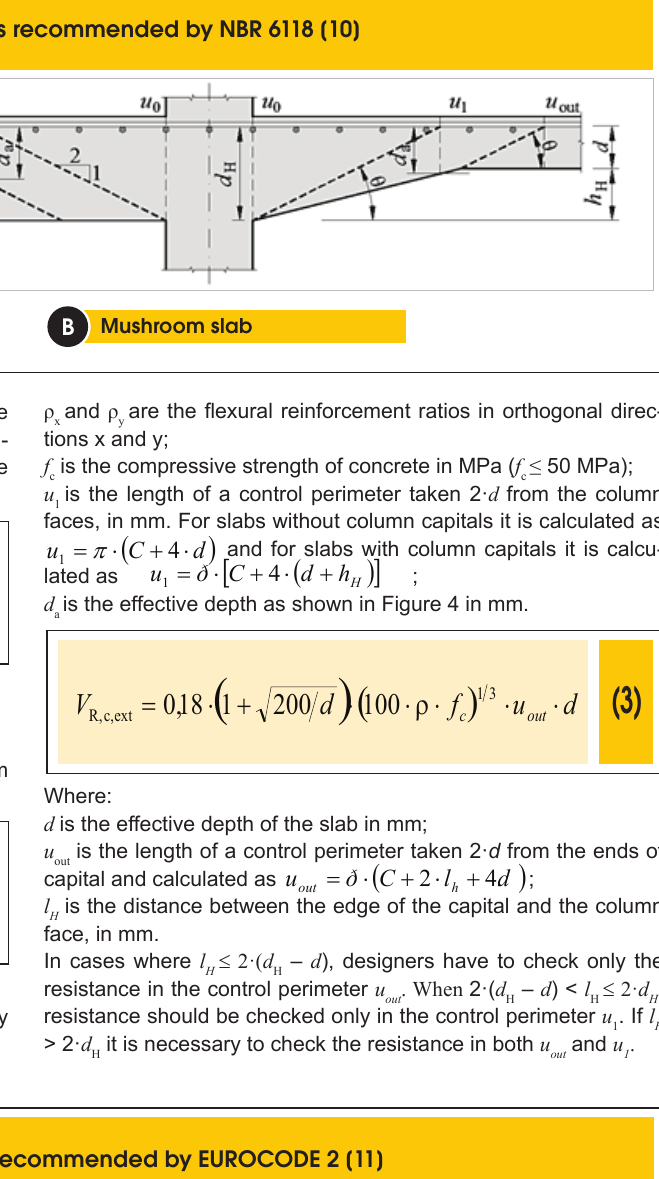
Figure 5 – Control perimeters recommended by EUROCODE 2